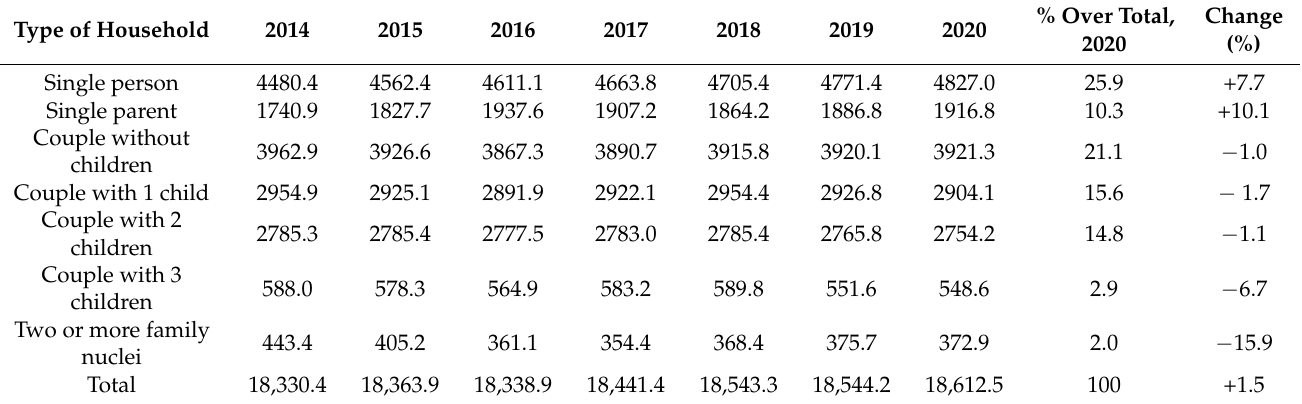
Table 1. Evolution of the number of households by type of household in Spain (in